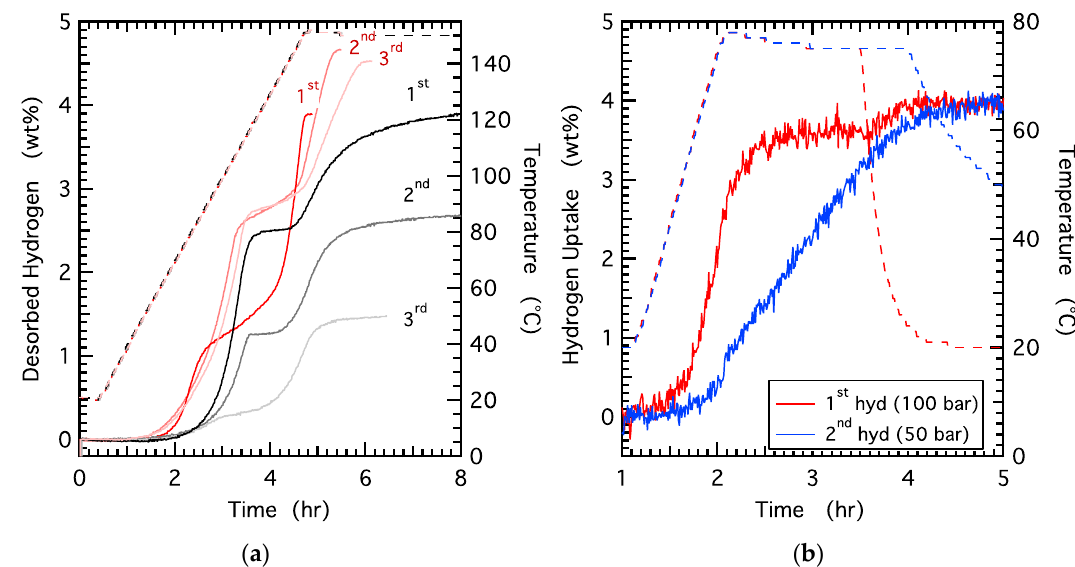
Figure 4. ( a ) Hydrogen desorption from 50/50 wt% NaAlH 4 /diglyme (red, solid line) and NaAlH 4 control samples (black, solid line) across three cycles (each cycle shown in a lighter shade). Corresponding temperature profiles are indicated by the dashed lines. ( b ) Hydrogen uptake for the 50/50 wt% NaAlH 4 /diglyme sample at the first hydrogenation step under 100 bar pressure for 90 minutes (red, solid line) and the second hydrogenation at 50 bar for 120 minutes (blue, solid line); both cycles were performed at 75 °C (dashed lines).